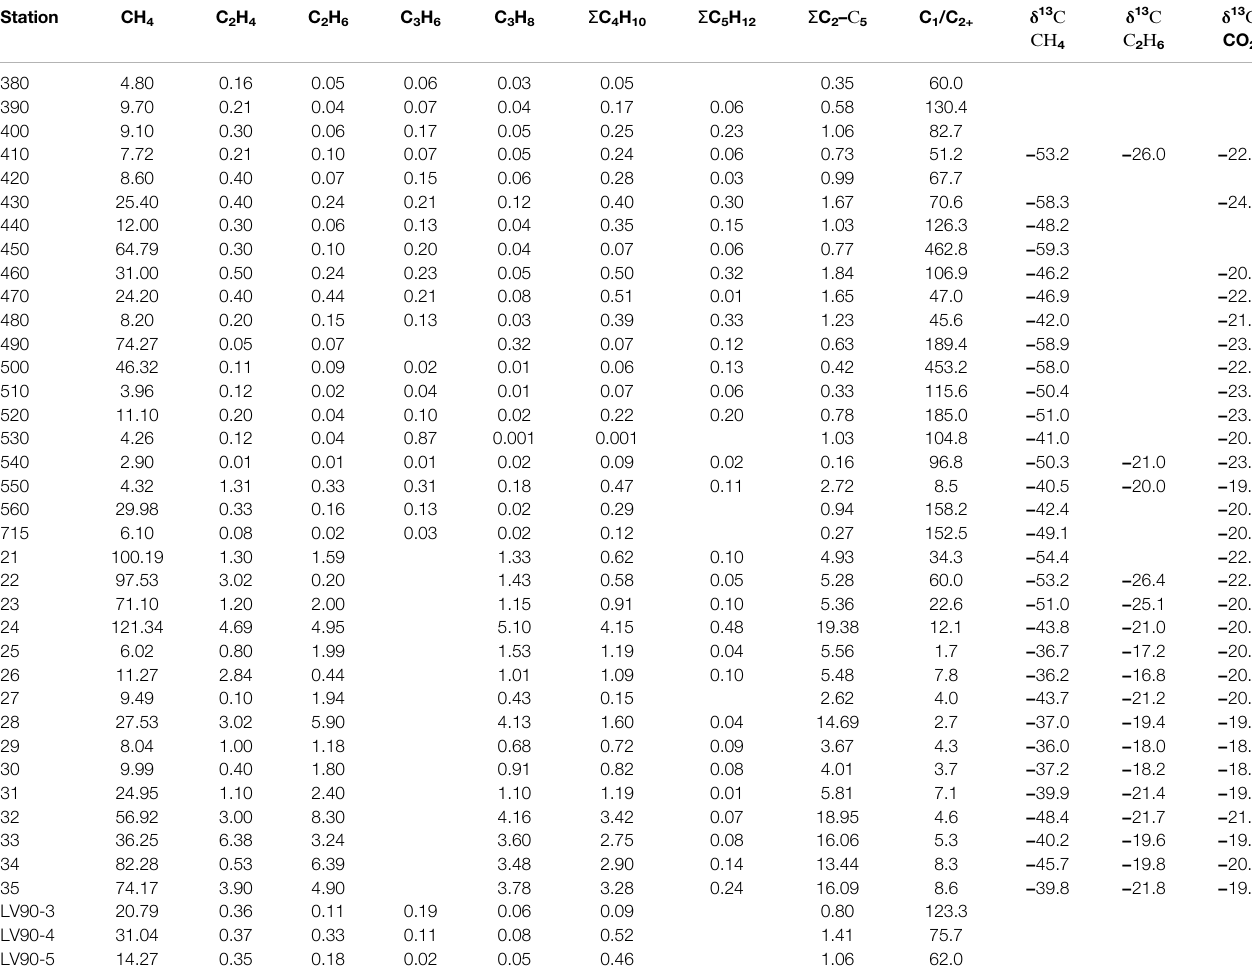
TABLE 2 | Average values of gas composition (ppm, 10 − 4 vol%), C 1 /C 2+ ratio, and carbon stable isotope ratios of sorbed gases in sediments from study area.